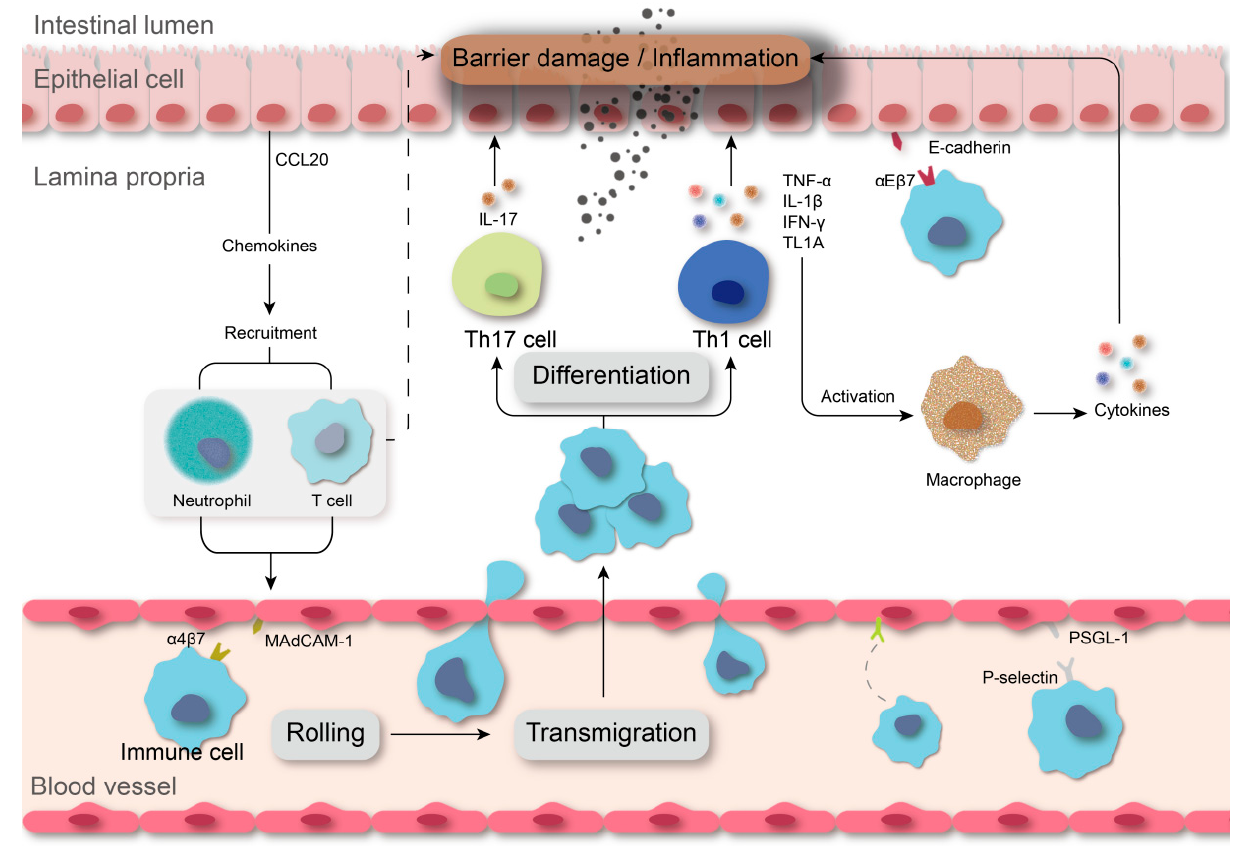
Figure 1. Immune cell homing and cytokine storming drive IBD progression. Lymphocytes roll, adhere, and transmigrate at the site of the lesion through the combined action of integrins, selections, and chemokines, with residence in the lamina propria. Excessive immune responses and ex- ternal stimulus synergistically lead to a proinflammatory cytokine storm hindering disease recov- ery.